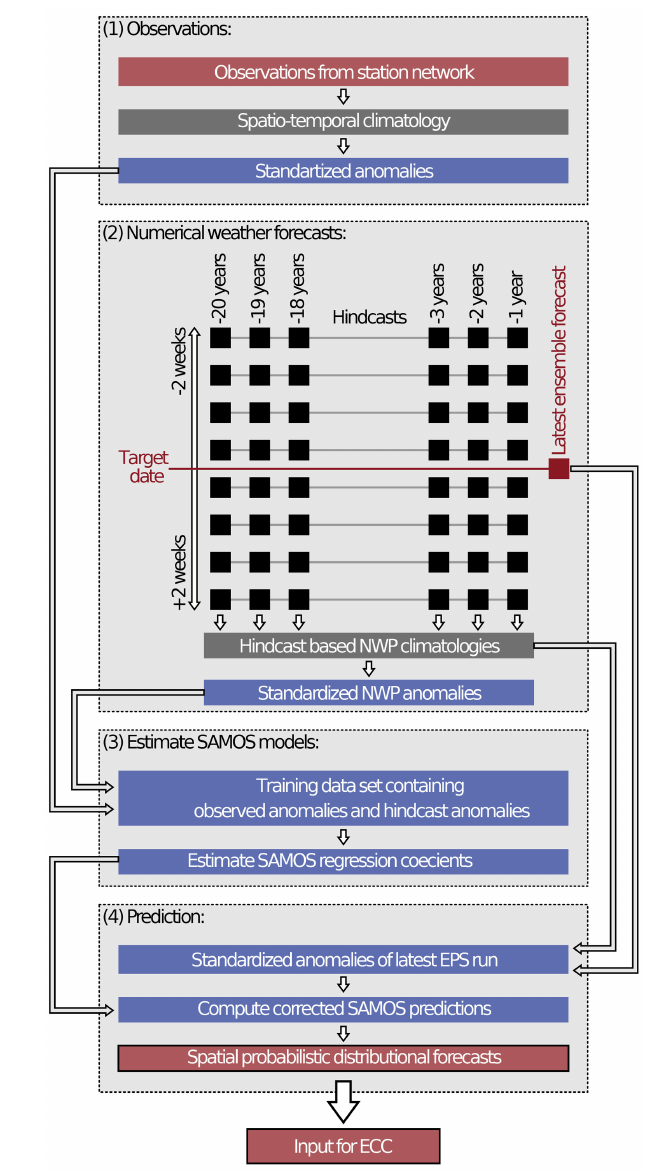
Figure A1. Schematic concept of the SAMOS postprocessing based on ECMWF hindcasts (black), ECMWF EPS forecasts (red), and observations (orange). Background climatologies (gray) are used to convert the data from the physical scale into standardized anomalies (blue) used to estimate the regression coefficients of the SAMOS postprocessing method. The SAMOS correction can be ap- plied to the standardized anomalies of a new EPS forecast to obtain spatial or spatio-temporal probabilistic forecasts (full distribution). These results are used as input for the ECC